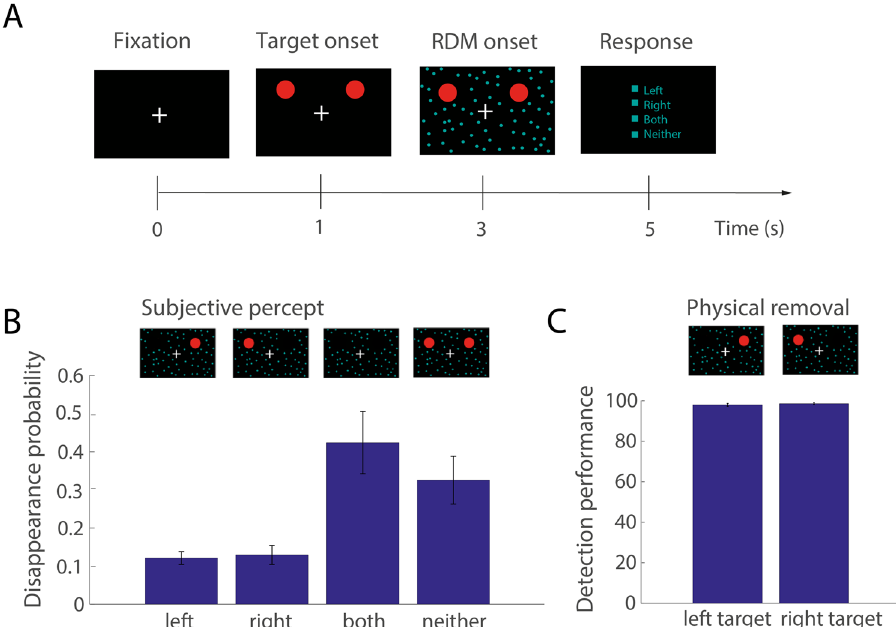
Figure 1. Generalized flash suppression (GFS) paradigm and perceptual results. ( A ) Each experimental trial began with central fixation, followed by the onset of two salient red target stimuli in the upper left and right visual hemifield. After the target had been presented for 2 s, a random dot motion (RDM) stimulus was shown, resulting in the disappearance of one or both target stimuli in a subset of trials. After each trial, subjects reported whether the left, the right, both or neither target had disappeared by selecting one of the options with a mouse click. Stereoscopy was achieved using red-green anaglyphic glasses. ( B ) Mean probabilities of the left, right, both or neither target disappearing for all 27 subjects. Corresponding subjective percepts are illustrated above the respective bars. ( C ) Percentage of correct reports of physical removal of the left or the right target during the control conditions. In all plots, error bars indicate + / − 1 SEM across